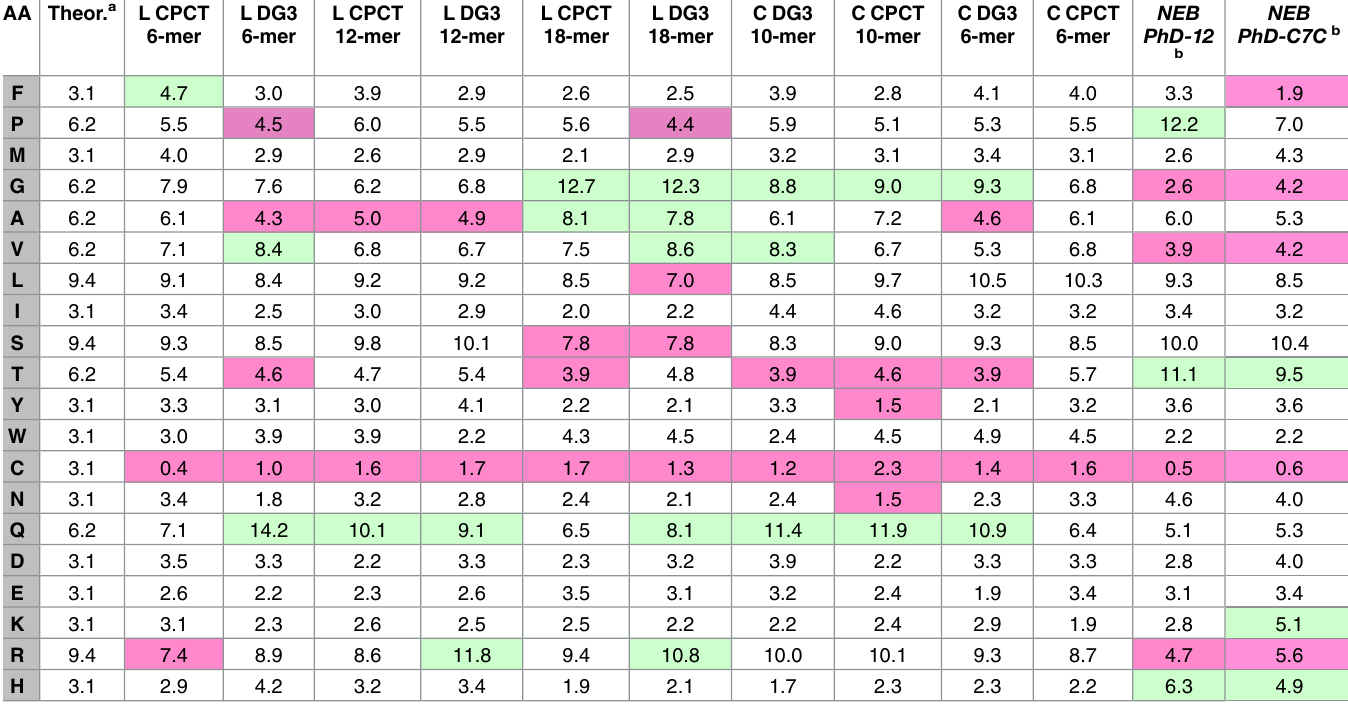
Table 1. Actual vs .theoreticalpercentageof each aminoacid in peptidehelpercell secondary librariesand commercial peptidelibraries. AA Theor. a L